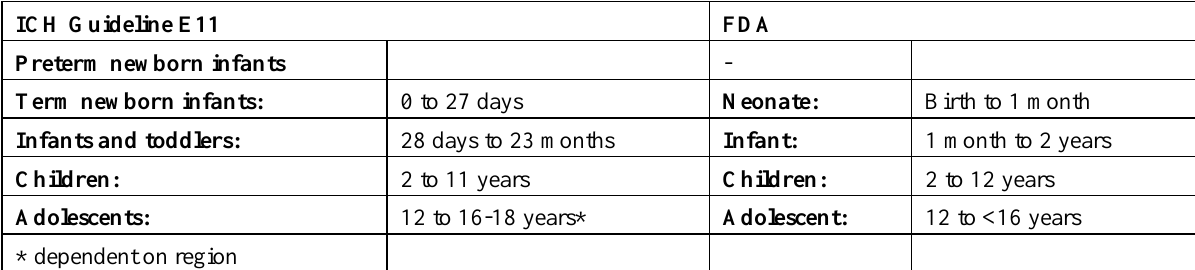
Table 3. Classification of pediatric age categories